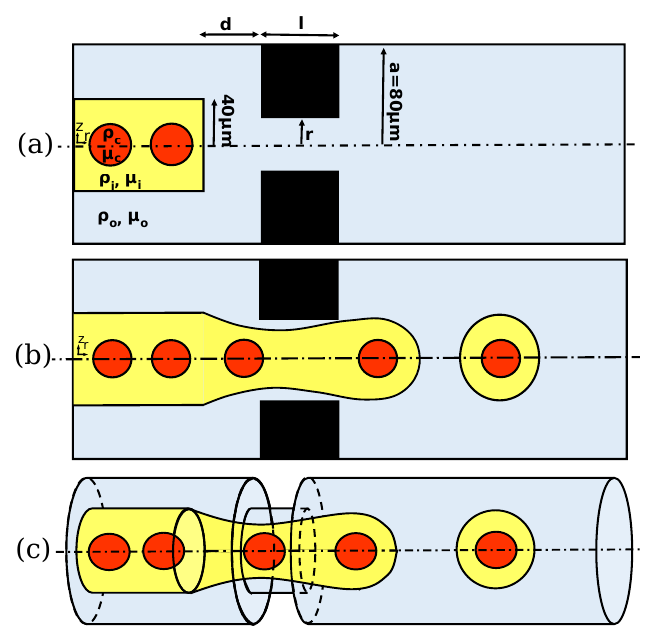
Figure 1. The schematic illustration of the flow-focusing geometry and encapsulation process: ( a ) initial position; ( b ) after pinch-off of the compound droplet; ( c ) 3D illustration of the encapsulation